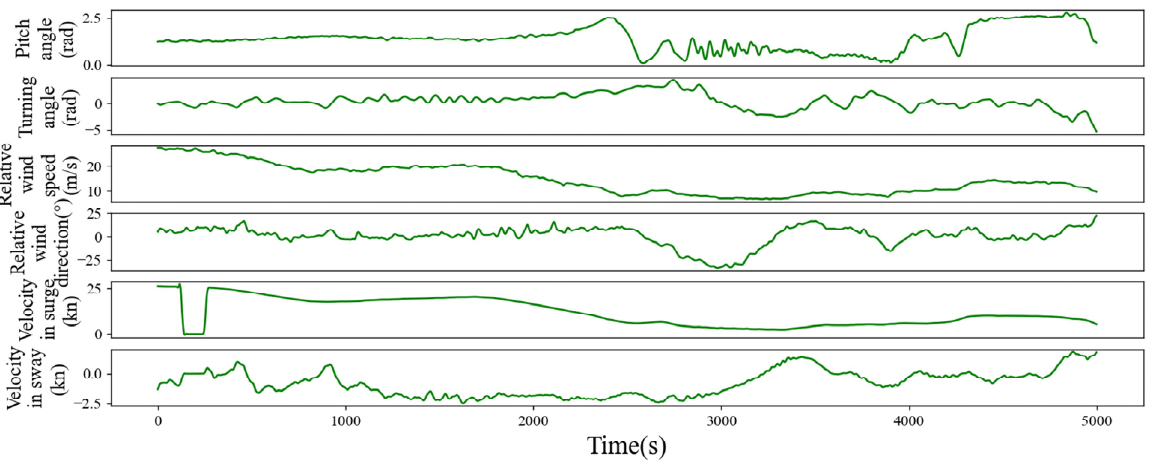
Figure 9. Partial raw data of the ship motion.